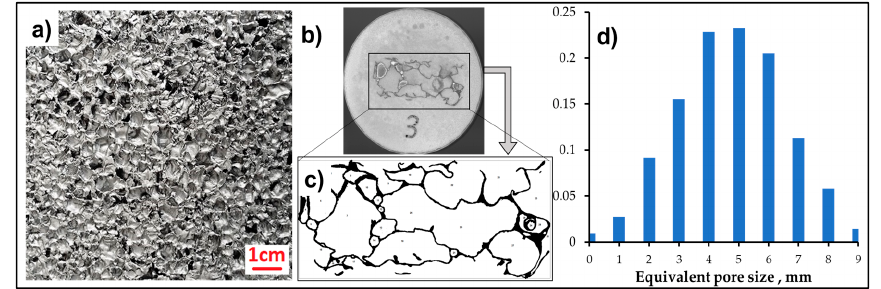
Figure 1. ( a ) Closed-cell Al-alloy foam, ( b ) scanned image of resin embedded Al-alloy foam (representative) sample used for pore size/distribution analysis, ( c ) adjusted black and white layout (binarization) of Al-alloy foam surface by Image J software and the Identification of pores per unit area, and ( d ) the average equivalent pore size distribution.